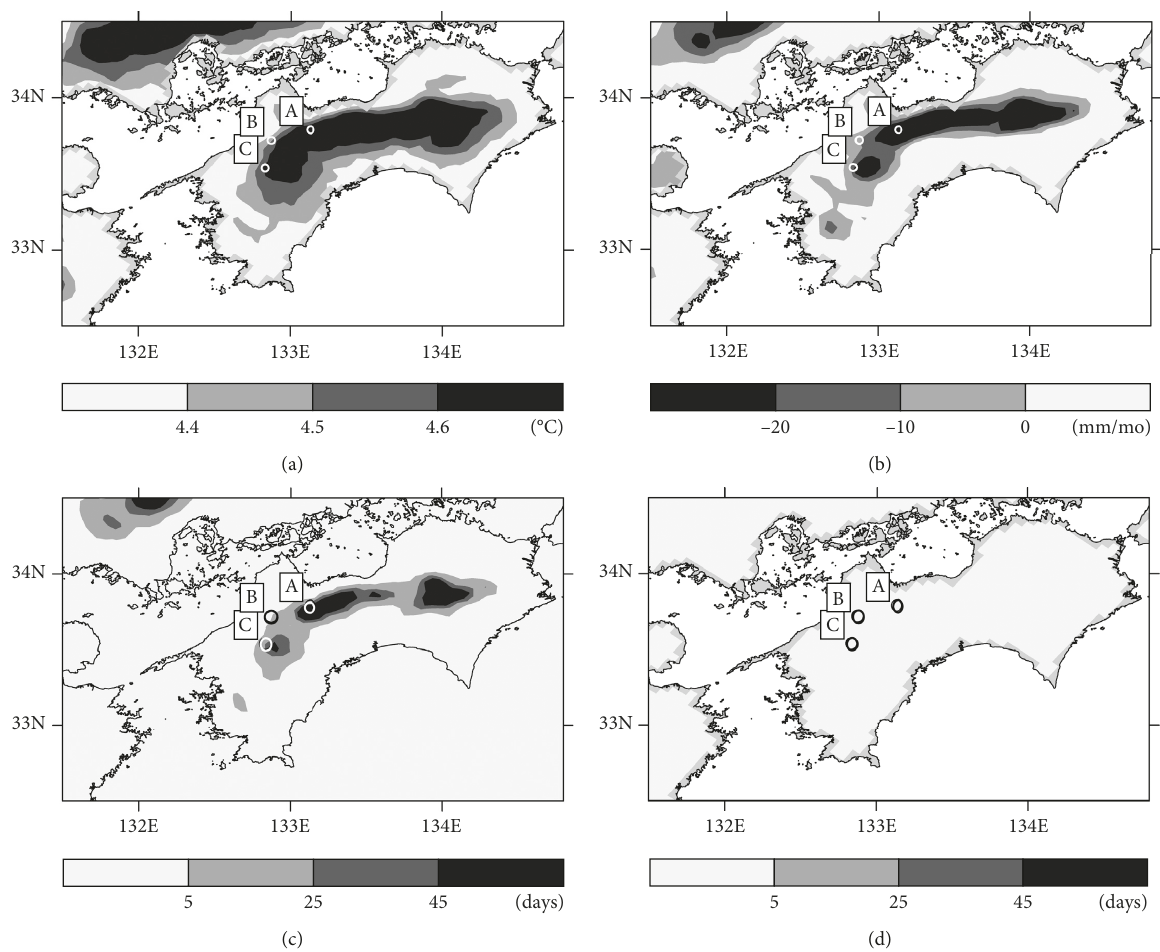
Figure 4: Projected future changes of (a) surface air temperatures (future-current) and (b) precipitation (future-current) for ski season (December–March average). Current period is 1981–2000, and future period is 2076–2096 under the RCP8.5 scenario. Ensemble averages are used for future values. (c) and (d) show the number of days with snow accumulation greater than 30 cm for current and future periods, respectively. Black and white circles indicate locations of fields A, B, and C.